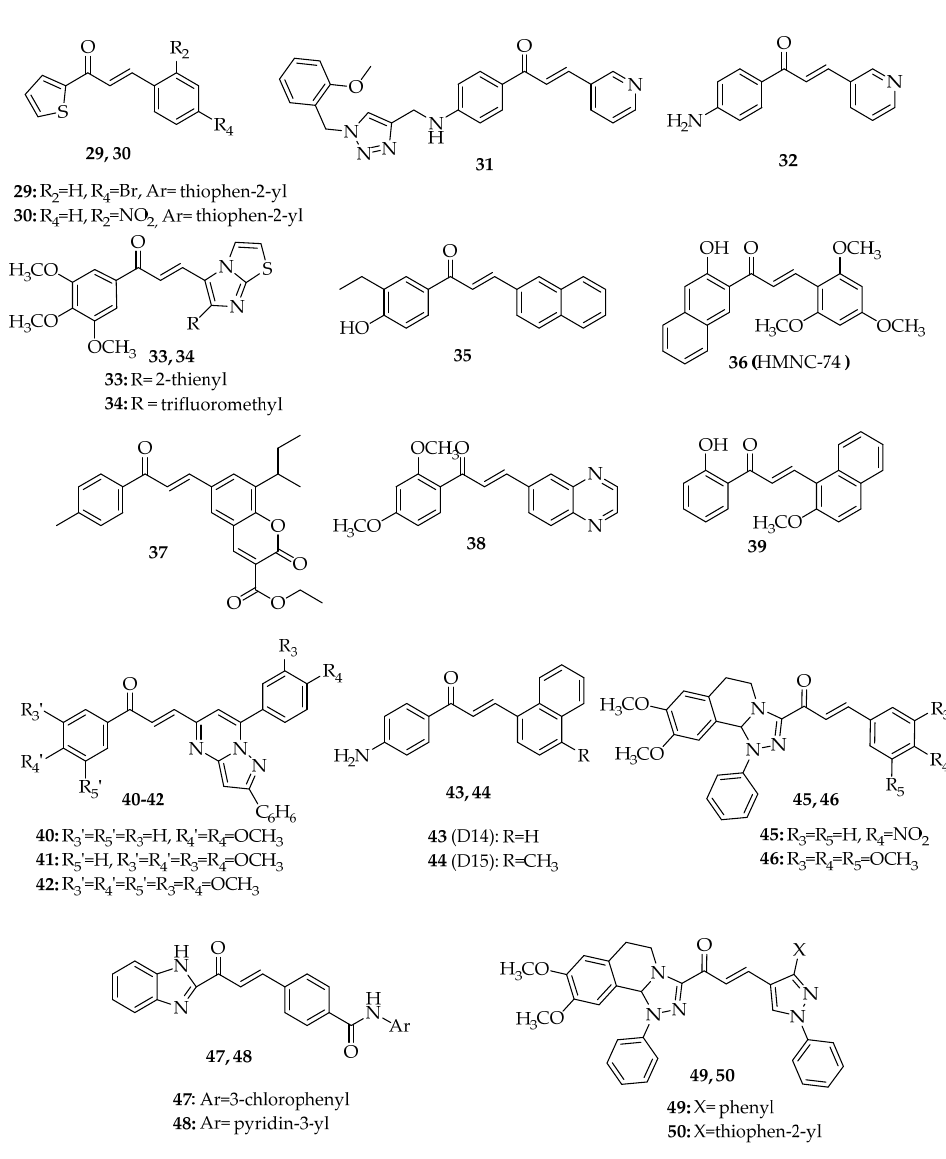
Figure 6. Structure of chalcones 29 – 50